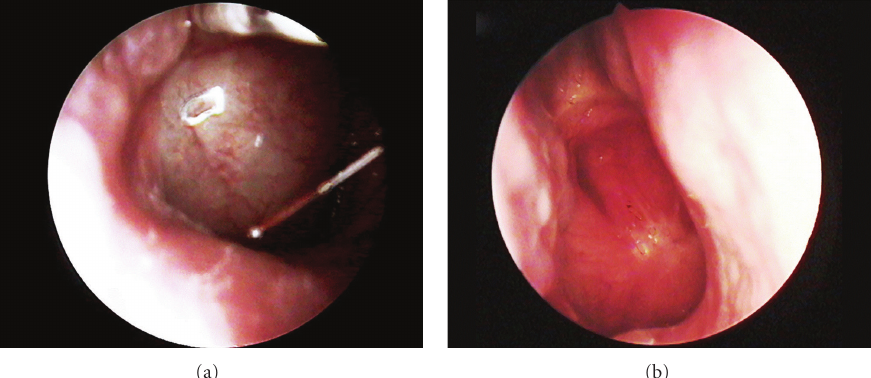
Figure 1: (a) Preoperative endoscopic image of the right-sided tumor situated at the posterior wall of the nasopharynx. (b) Endoscopic follow-up image of the nasopharynx 14 months after postoperative radiotherapy.